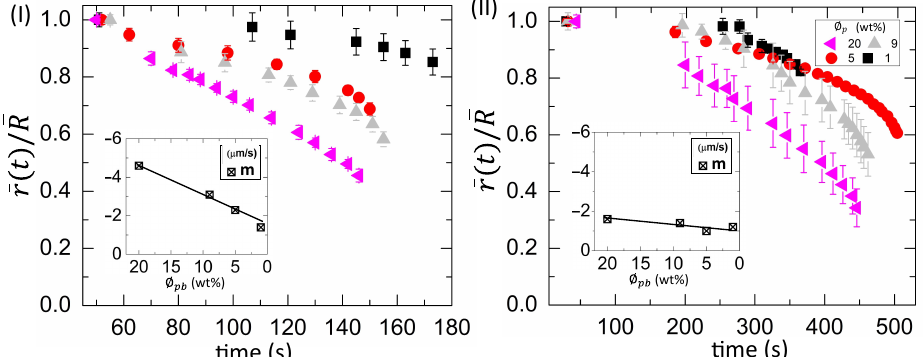
Figure 10. Time evolution of the averaged fluid front radius ( r ( t ) ) that is normalized with the averaged radius of the droplet ( R ) at the different initial concentration ( φ p ) ranging from 20 to 1 wt% in the BSA droplets at different substrate temperature (T) of 55 ◦ C in ( I ) and 25 ◦ C in ( II ). The slope values ( m ) are calculated from the whole range by plotting the r ( t ) vs. time. The variation of m with φ p is exhibited in the insets of ( I ) and ( II